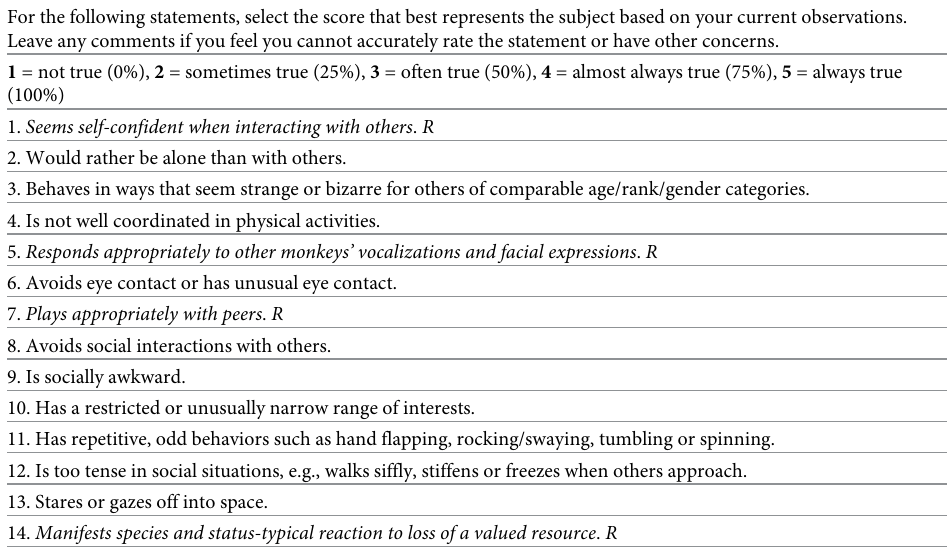
Table 2. List of items included in the jmSRS and criteria for scoring based on the 1–5 likert rating scales. For the following statements, select the score that best represents the subject based on your current observations. Leave any comments if you feel you cannot accurately rate the statement or have other concerns. 1 = not true (0%), 2 = sometimes true (25%), 3 = often true (50%), 4 = almost always true (75%), 5 = always true